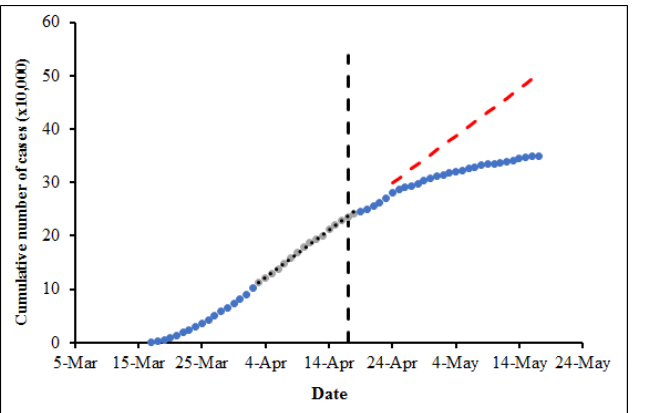
Figure 3. Cumulative number of COVID-19 cases (blue dotted line) between 17 March–17 May 2020 for New York state. Vertical black dash line indicates the onset of FC mandate (17 April 2020). Linear regression (black dotted line) through the data was used to predict pre-FC mandate infection data trend. The red dash line denotes projection based on linear regression of cases without FC mandate. The difference estimated the number of cases prevented by FC mandate.